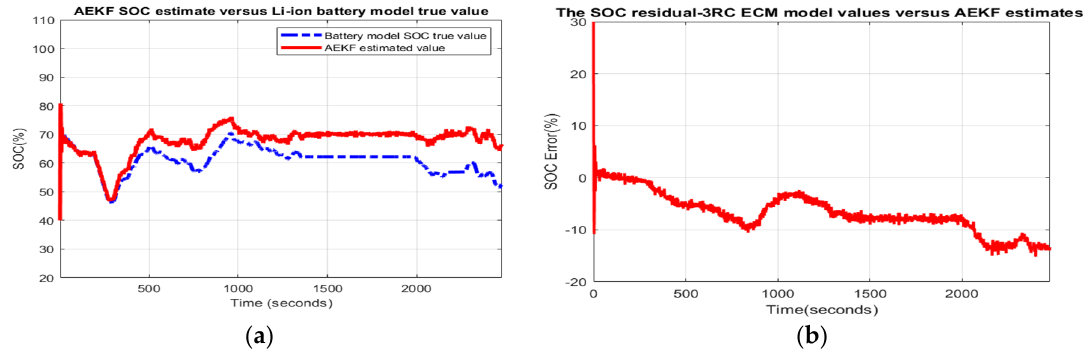
Figure A14. Robustness to simultaneous changes, SOCini = 0.4, σ noise = 0.01; ( a ) AEKF SOC value versus battery model true value; ( b ) SOC residual.